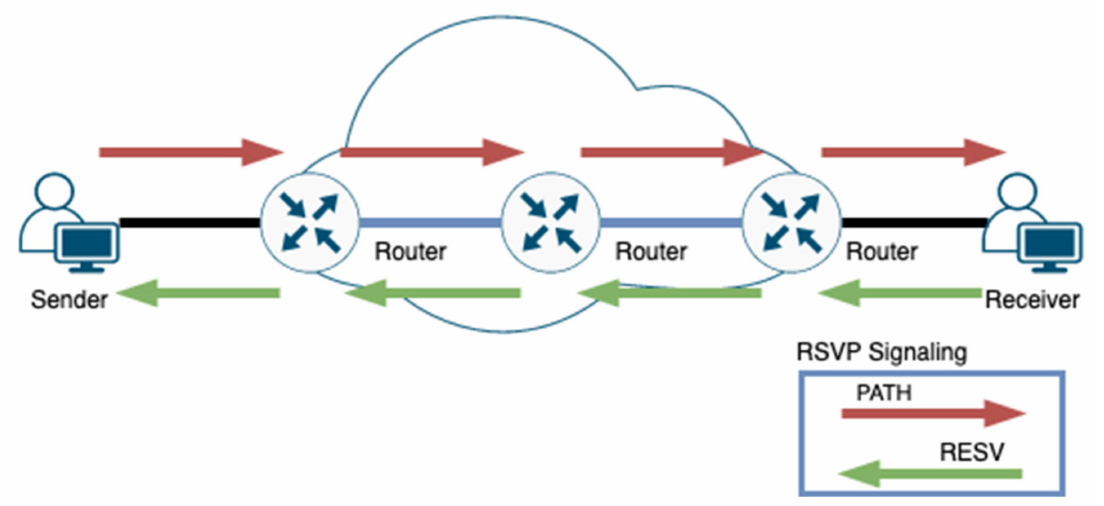
Figure 1. IntServ Operational